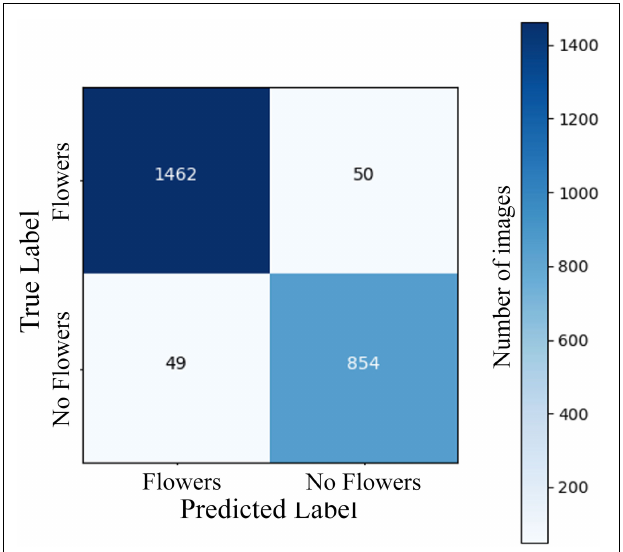
FIGURE 1 | A confusion matrix showing model predictions vs. expert assigned labels for a CNN predicting 2-stage phenology of A. petiolata in a validation set of 2,415 iNaturalist images. Rows represent true labels of images, assigned by an expert annotater, columns represent label assigned by the CNN, and the numbers in cells represent the number of images within each category. Cells on the diagonal from the top left to bottom right represent correct model classifications. Overall CNN accuracy was 95.9%. The CNN was constructed using ResNet 18 and trained on 9,662 images of A. petiolata from